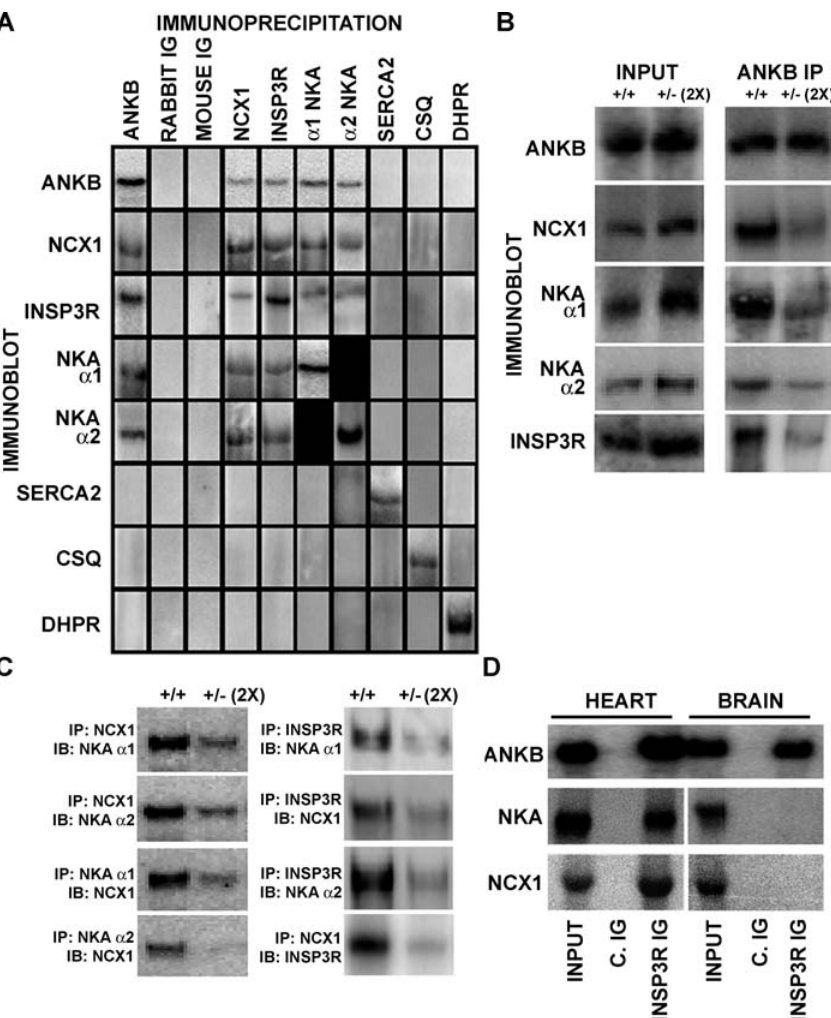
Figure 4. Ankyrin-B Forms a Macromolecular Complex with NKA, NCX1, and InsP 3 R That Is Missing in Ankyrin-B þ / (cid:1) Heart (A) Immunoprecipitations and co-immunoprecipitations from detergent-soluble extracts from adult mouse heart. (B and C) Detergent-soluble lysates from wild-type or ankyrin-B þ / (cid:1) mouse hearts were used for immunoprecipitations with indicated antibodies (IB, immunoblot; IP, immunoprecipitation). Immunoprecipitations of ankyrin-B þ / (cid:1) extracts employed doubled amounts of input lysate to compensate for 50% reduction of ankyrin-B. (D) InsP 3 R co-immunoprecipitates 220-kDa ankyrin-B, NCX1, and NKA from detergent-soluble heart lysates (Input ¼ 10%). In contrast, InsP 3 R co- immunoprecipitates 220-kDa ankyrin-B, but not NCX1 or NKA, from detergent-soluble lysates of mouse brain (Input ¼ 10%). ANKB, ankyrin-B; C. IG, control Ig. DOI: